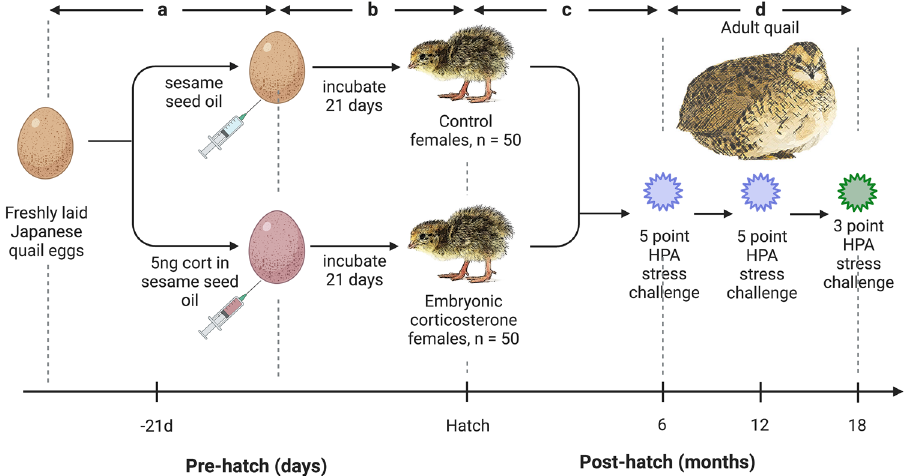
Figure 1. Experimental design timeline. ( A ) Freshly laid eggs were injected with sesame oil (control) or corticosterone in sesame oil within 24 h of being laid. ( B ) Injected eggs were incubated for 21 days, and after hatch chicks were sexed and a total of 100 female birds were included in the experiment (n = 50 each group). ( C ) Birds remained in the brooder for 4 weeks and then were transferred to pens. ( D ) HPA acute stress series were repeated throughout adult life, with 5-point challenges occurring at 6 and 12 months of age, and a 3-point challenge occurring at 18 months of